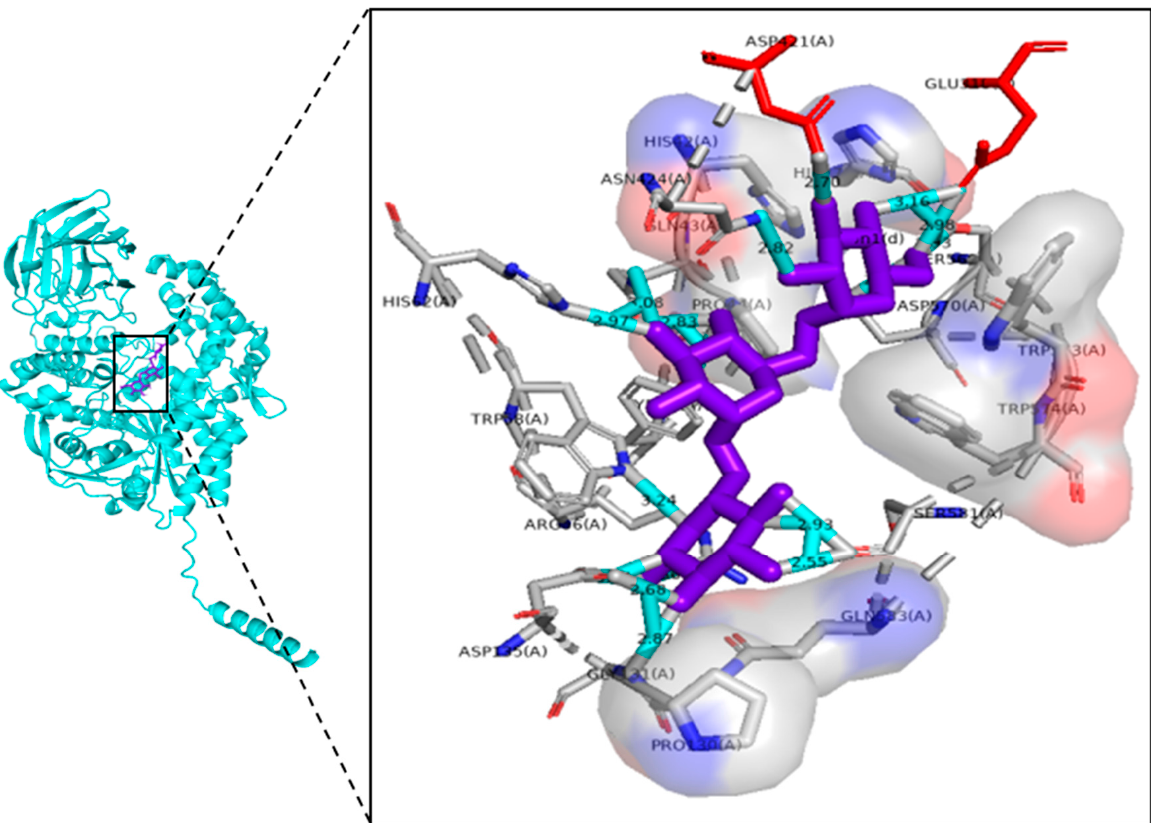
Figure 8. Pul-HJ Δ 782 molecular docking results. The purple-colored structure is isomaltotriose. Figure 8. Pul-HJ ∆ 782 molecular docking results. The purple-colored structure is